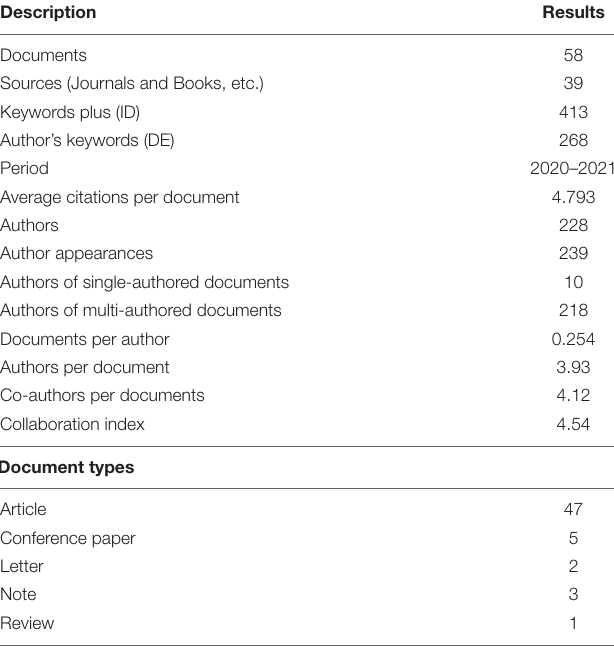
TABLE 1 | Description and distribution of main information.